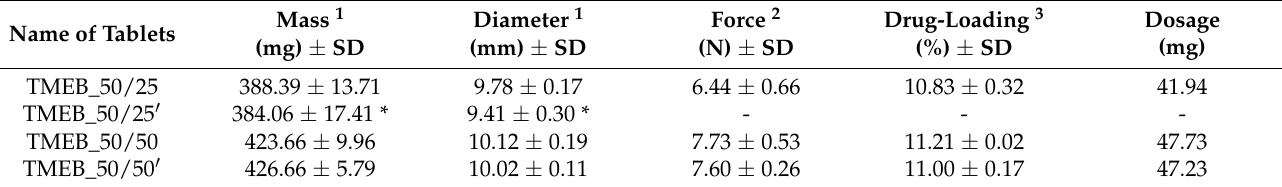
Table 7. Characteristics of MEB-loaded